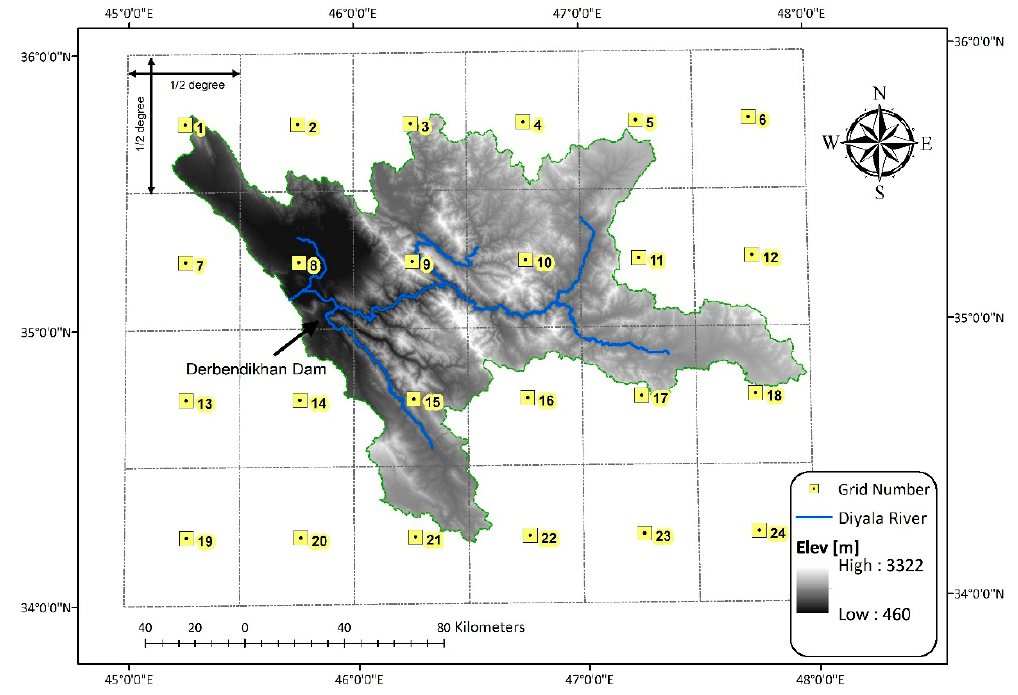
Figure 3. Diyala River basin in Iraq with grid-cell numbers.